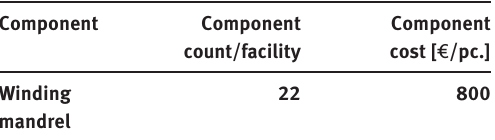
Table 6 Necessary tool costs per winding machine — all components are assumed to be replaced one time during manufacturing time.